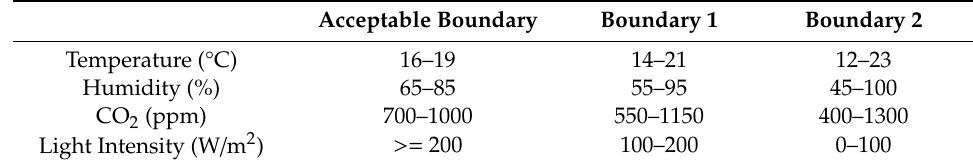
Table 3. Boundaries of control parameters in building the greenhouse.